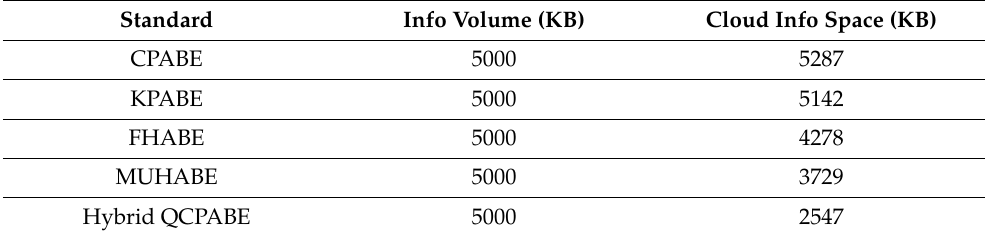
Table 2. Memory occupancy efficacy of proposed standard vs. conventional ABE standards.